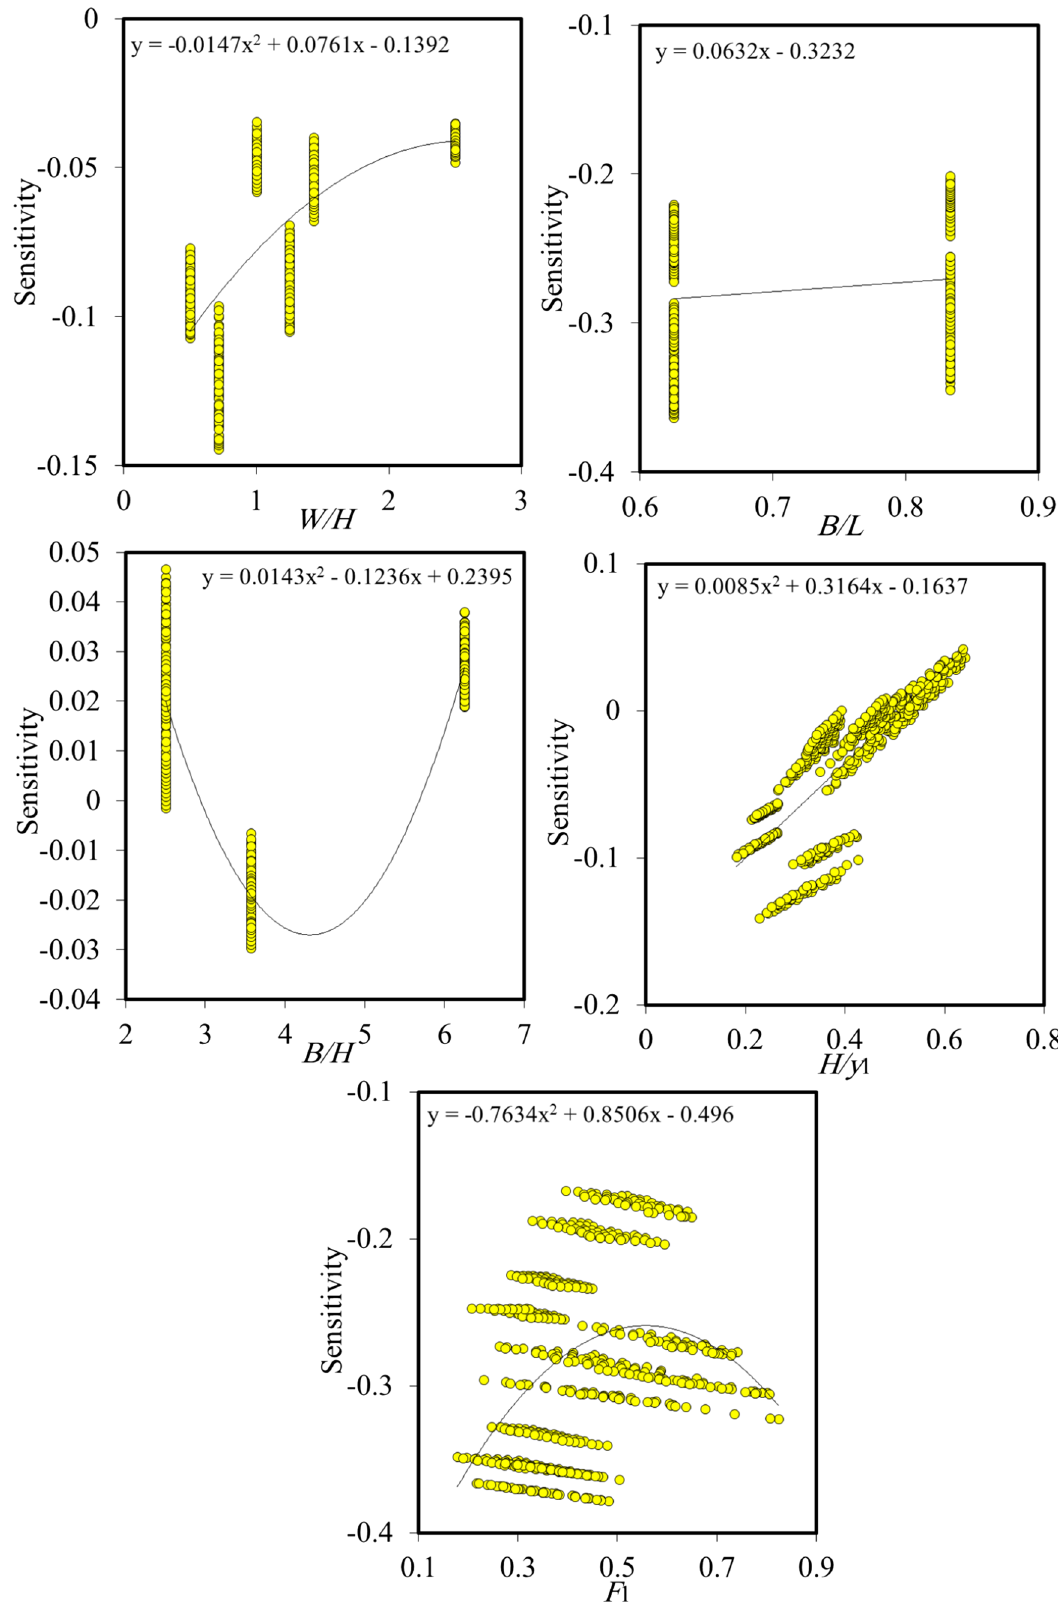
Fig. 15 PDSA results for